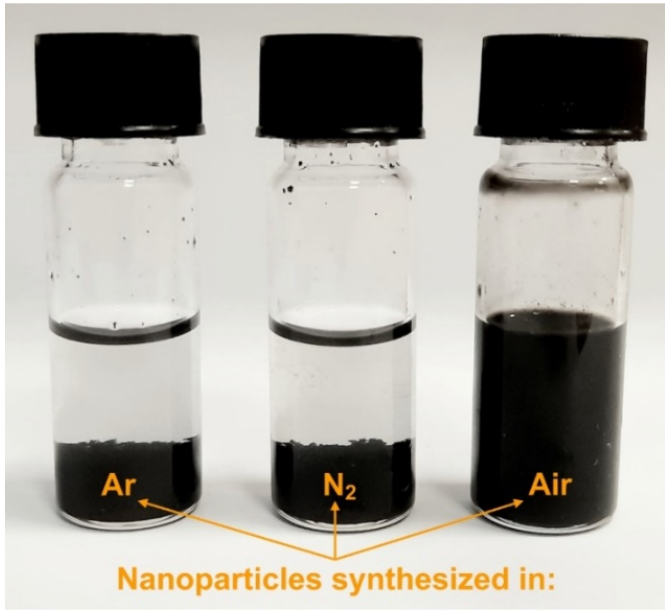
Figure 9. Photo of the prepared suspensions (nano-inks) with Pt nanoparticles (25 wt.%) dispersed in ethylene glycol (EG) with polyvinylpyrrolidone (PVP). In view of this, further experiments to optimize the composition of nano-ink for AJP were carried out only using oxidized PtNPs synthesized in an air atmosphere. Based on the results of optimization studies using nanoparticles synthesized under air, it was determined that the concentrations of nanoparticles and binder in nano-ink for the implementation of the AJP process should be 25 wt.% and 4 wt.%, respectively. In this case, the surface tension and viscosity of the optimized nano-ink were 43.9 mN/m and 11.4 cP, respectively. The optimized composition and parameters of Pt nano-ink based on nanoparticles synthesized by spark discharge under air are presented in Table 2. Table 2. Platinum nano-ink parameters optimized for aerosol jet printing (AJP) process. Composition Ethylene glycol (EG),